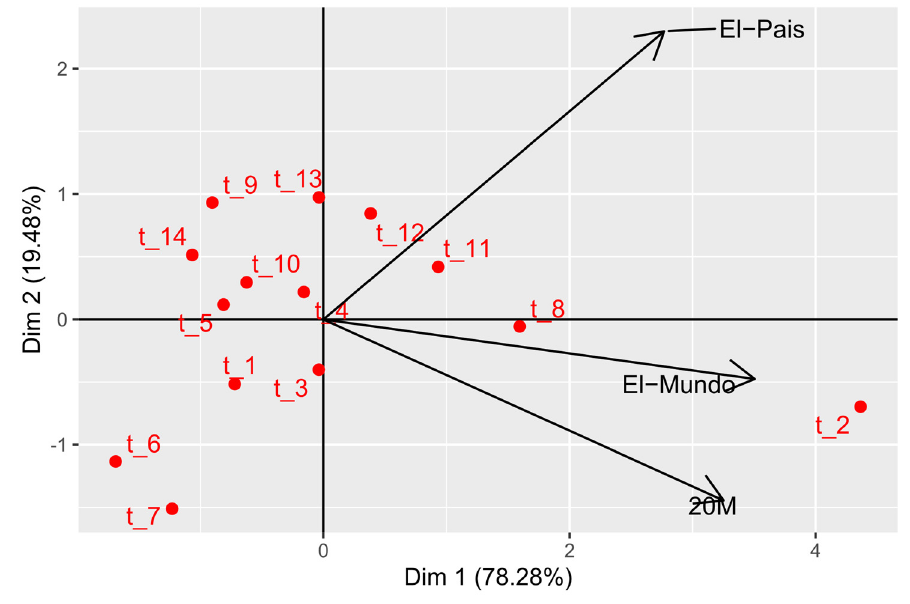
Figure 8. HJ-biplot of topics obtained in LDA.